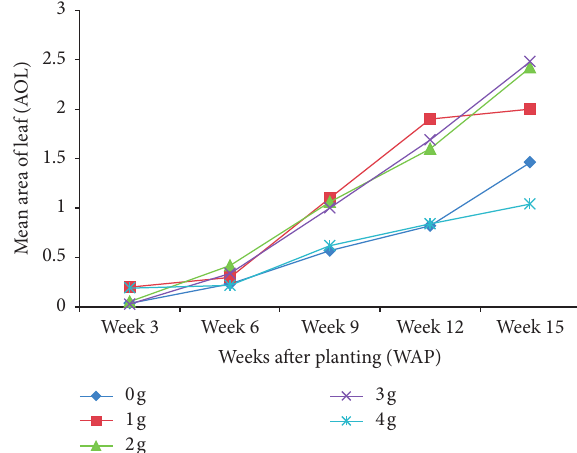
Figure 3: Mean leaf area of Punica granatum 15 weeks after planting.